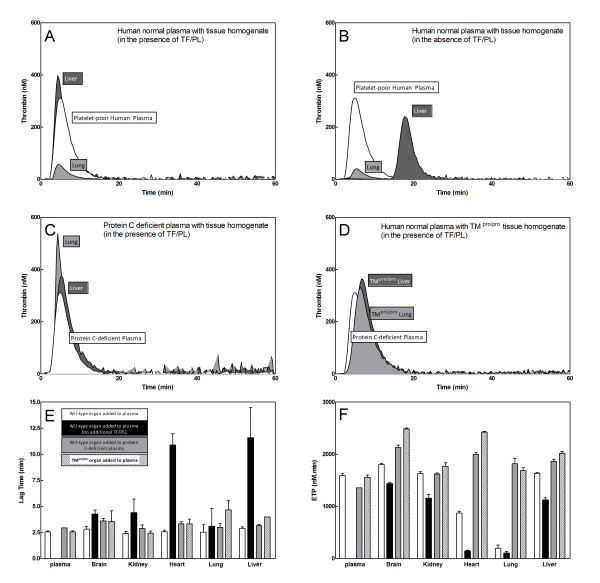
Influence of lung and liver tissue homogenate on thrombin generation in plasma. Lung (light grey curve) or liver (dark grey curve) homogenates were added to human normal plasma with additional TF (5 pM) and PL (4 μM) (Panel A) or in the absence of additional TF and PL (Panel B). For comparison, thrombin generation in human normal plasma triggered with 5 pM TF and 4 μM PL is plotted (white curve) in panels A, B, C, and DPanel C: Addition of lung (light grey curve) or liver (dark grey curve) homogenate to protein C deficient plasma (Panel C) in the presence of additional TF/PL. Panel D: Addition of lung (light grey curve) or liver (dark grey curve) homogenates from TMpro/pro transgenic animals to platelet-poor human plasma. Panels E and F: overview of the lag time and ETP derived from thrombin generation curves for tissue homogenates added to platelet-poor human plasma in de absence of additional TF/PL (white bars) or in the presence of additional TF/PL (black bars), tissue homogenates added to protein C-deficient plasma (grey bars), and tissue homogenates from TMpro/pro transgenic animals to platelet-poor human plasma (hatched bars). Bars represent mean ± SD from 6 tissue homogenates.